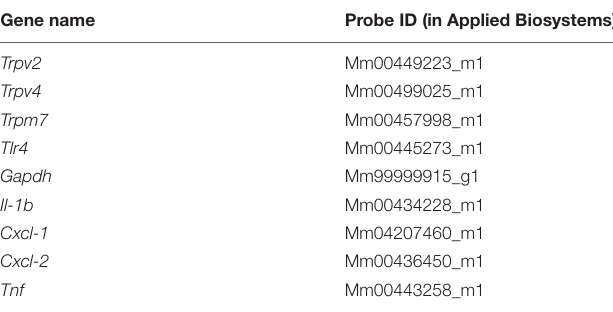
TABLE 1 | List of TaqMan